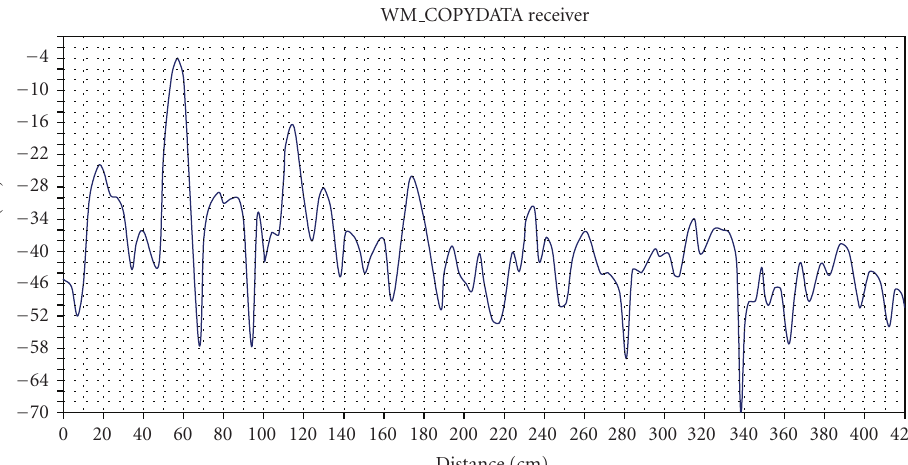
Figure 13: A scan measured with SFCW radar after matched filter calibration procedure is